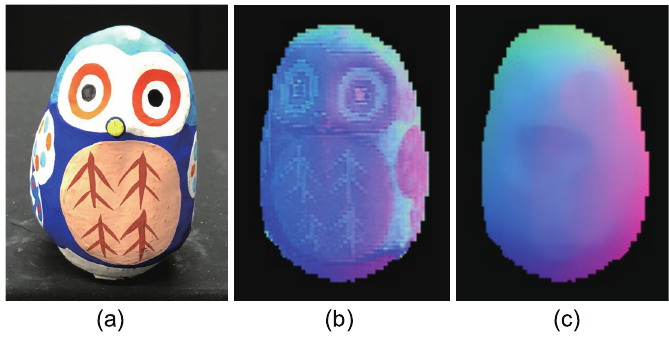
Figure 16. The results for owl object, which only causes diffuse reflection. Estimated surface normal [owl]: ( a ) Target object, ( b ) surface normal of naive color photometric stereo, and ( c ) surface normal of our method. The proposed method is not affected by the albedo